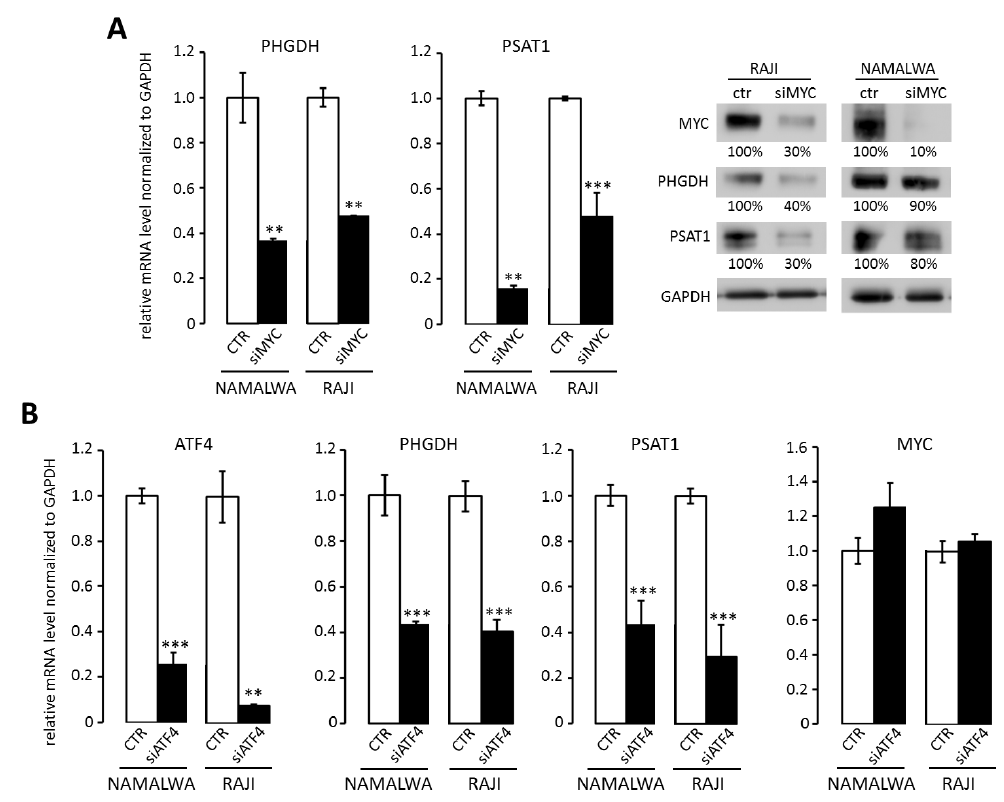
Figure 2. MYC regulates PHGDH and PSAT1 expression through ATF4 transcription factor. ( A ) MYC silencing decreases PHGDH and PSAT1 transcript and protein levels in RAJI and NAMALWA BL cell lines. Representative Western blots showing PHGDH and PSAT1 protein abundance after MYC silencing are shown. Protein abundance was quantified by densitometry using ImageJ software and presented as % of control. ( B ) The knockdown of ATF4 transcription factor decreases PHGDH and PSAT1 gene expression in BL cells. BL cells were transduced with siRNA targeting ATF4, incubated for 48 h, then the expression of ATF4, PHGDH, PSAT1, and MYC genes was analyzed with RQ-PCR. In ( A ) and ( B ), bar graphs represent averages of three independent experiments performed in technical triplicates, error bars represent standard deviation (SD). Statistical differences were assessed using t -test; * for p < 0.05; ** for p < 0.01 and *** for p < 0.001.